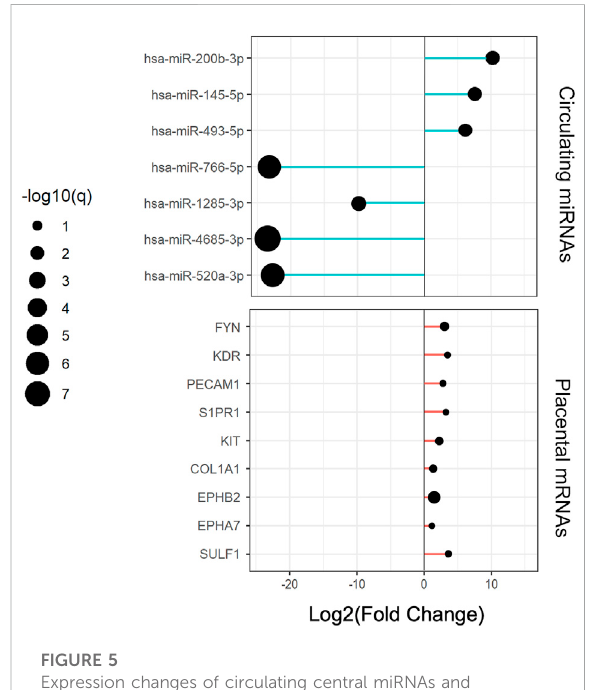
FIGURE 5 Expression changes of circulating central miRNAs and placental hub genes in RPL relative to the NP